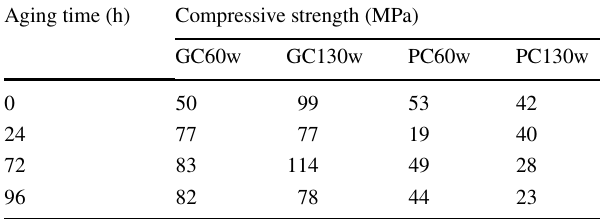
Table 2 Compressive strength development of geopolymer and class G cement expose into wet supercritical CO 2 at 60 °C and 130 °C